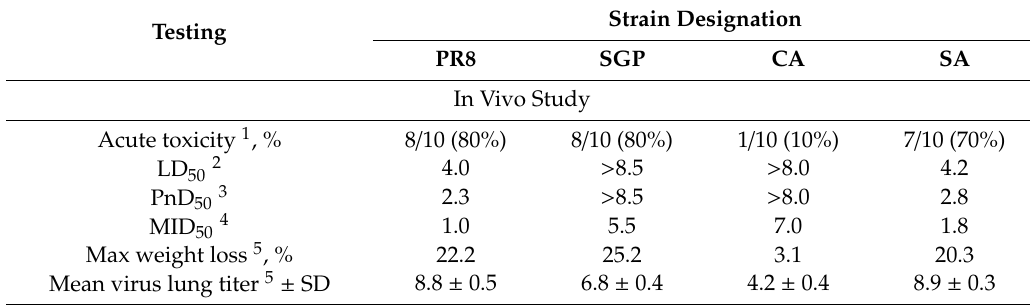
Table 2. The main characteristics of the influenza viruses tested in vivo and in